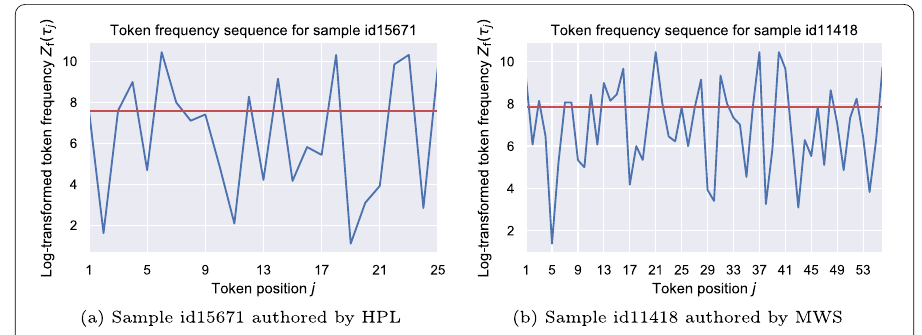
Figure 14 Examples of log-transformed token frequency sequences for HPL and MWS obtained from the respective medians of stylometric feature Quantile-Abs-Changes. The red horizontal lines indicate the (log-transformed) 60% percentiles, which are 7.59 for id15671 ( a ) and 7.85 for id11418 ( b